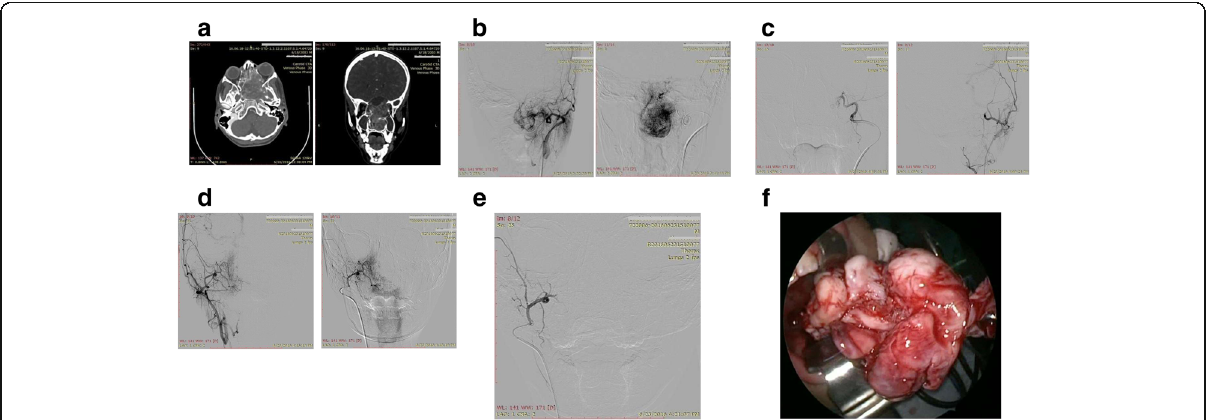
Fig. 2 A 13-year-old male patient presented by epistaxis and nasal obstruction. a Axial and coronal sections of CTA revealing a large hyper- vascular midline, more at the left side JNA. b DSA showing the aretrial blush of JNA using the macro- and micro-catheter at the left side. c Post- embolization angiogram via PVA particles showing total disappearance of the blush of the JNA through the micro- and macro-catheters after occlusion of the left internal maxillary artery (IMA). d DSA showing the arterial blush of the small right-sided component of the JNA using the macro- and micro-catheter. e Another post-embolization angiogram revealed disappearance of the arterial blush of the small right-sided component of the JNA after occlusion of the right IMA. f Post-embolization endoscopic image showing the excised relatively whitish large JNA which is reflecting adequate